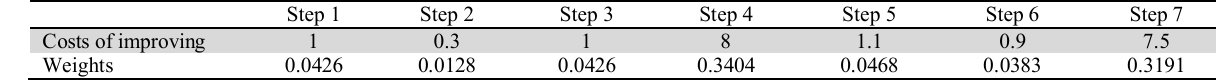
A comparison of how costly seven steps of improvement would